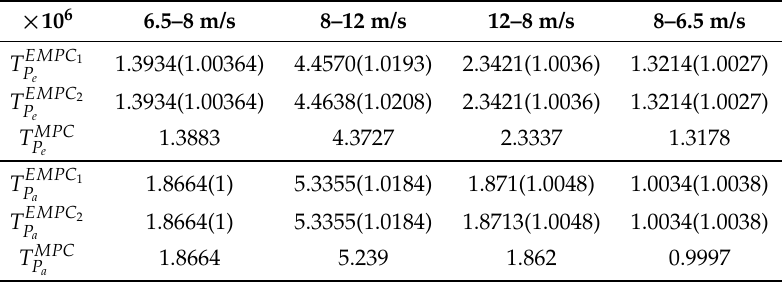
Table 3. Average economic performance under gradient wind.